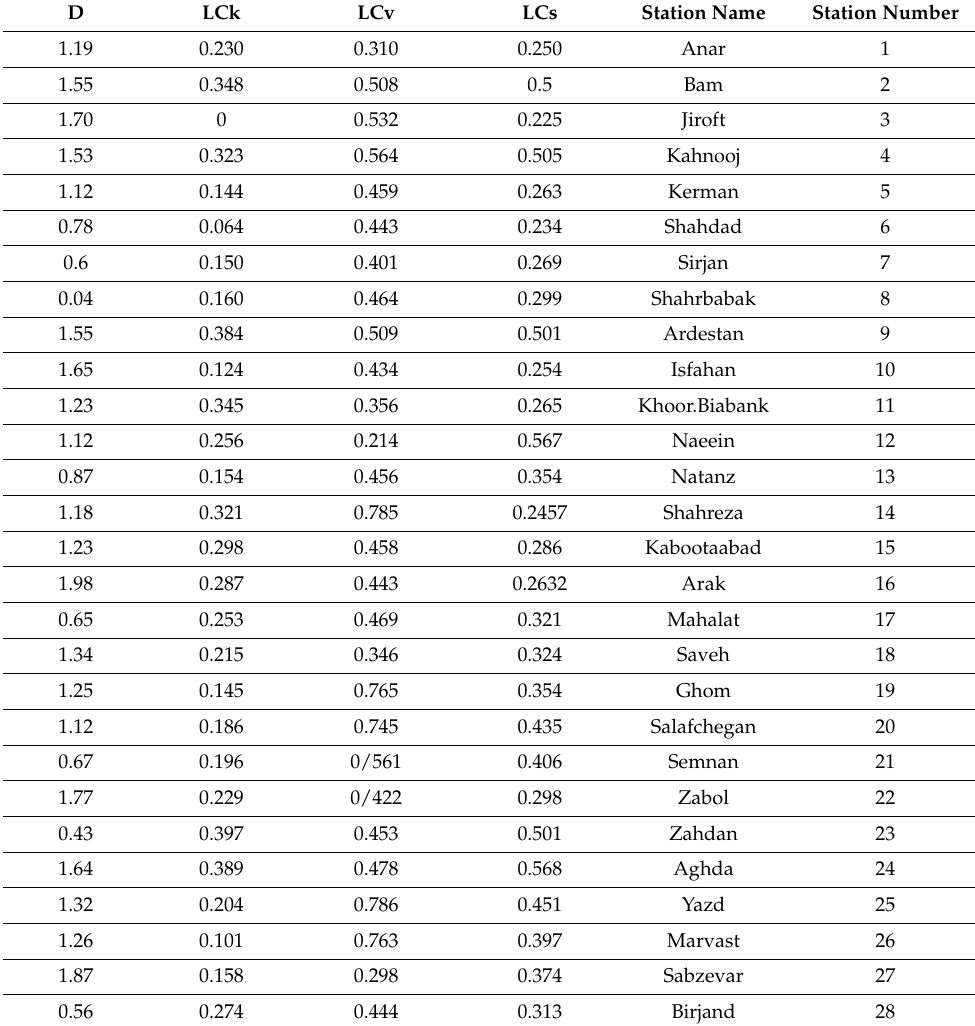
Figure 4. Diagram of linear moments L−CK, L−CS of the studied stations. Table 2. Descriptive statistics and linear moments of station